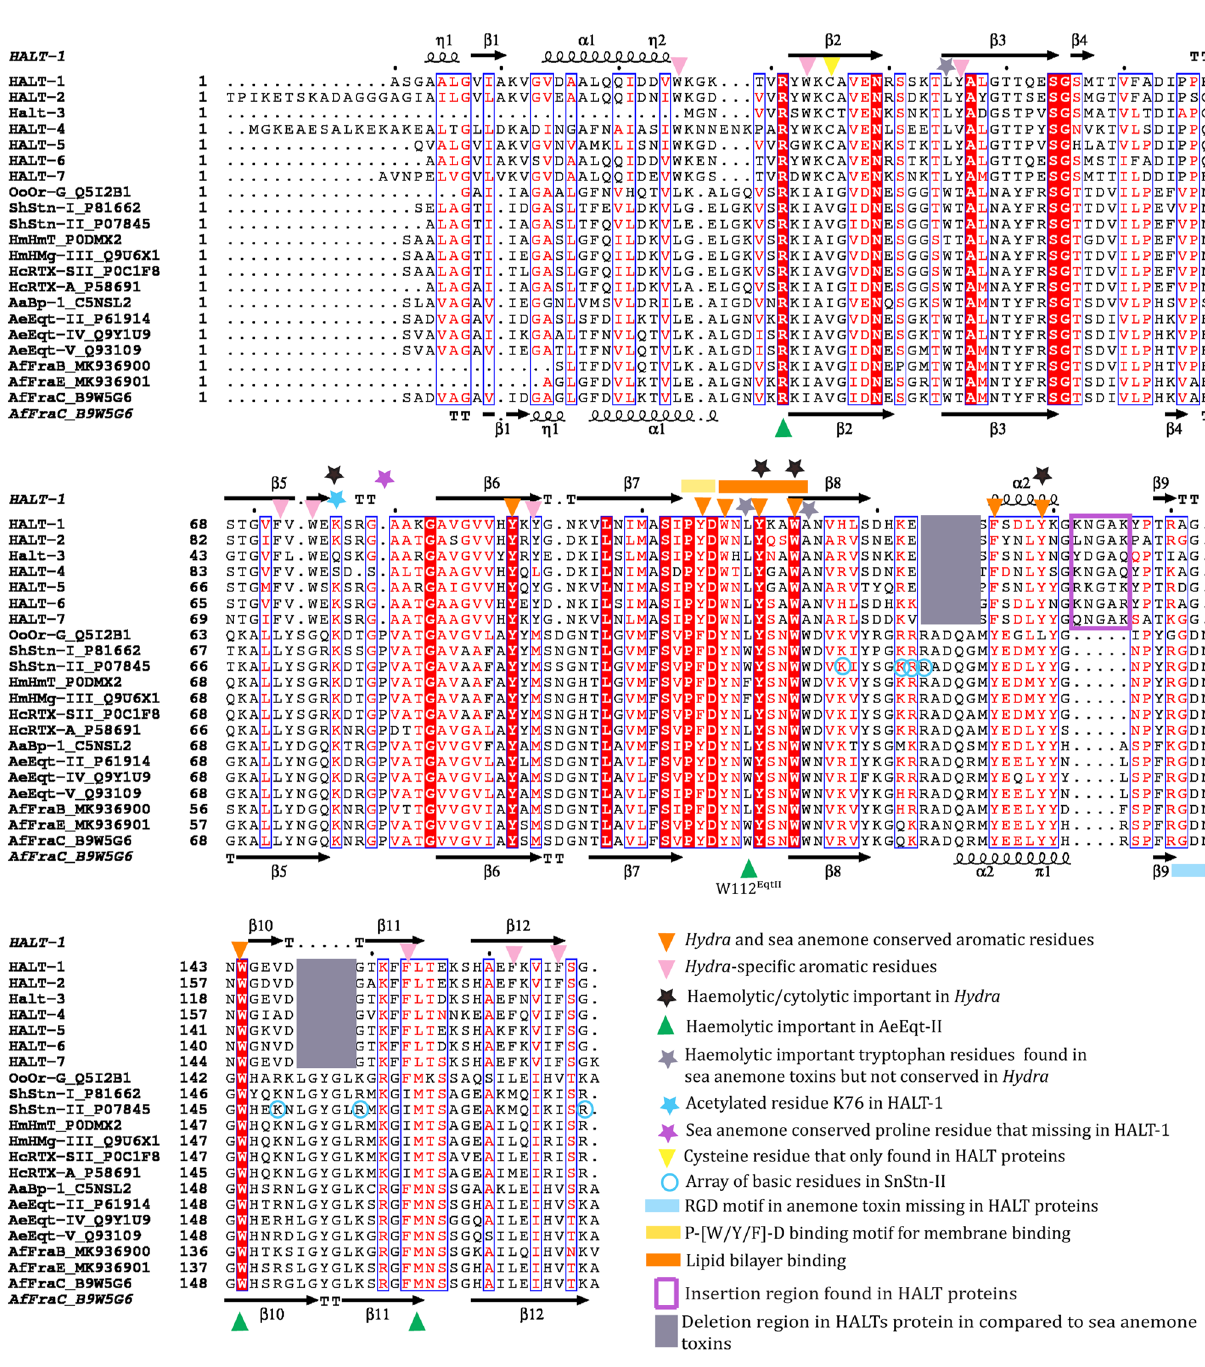
Figure 1. Multiple sequence alignment (MSA) of HALT proteins with actinoporin homologs from sea anemones. The naming system for the sequences is as follows: Actinoporin-name_Uniprot number.